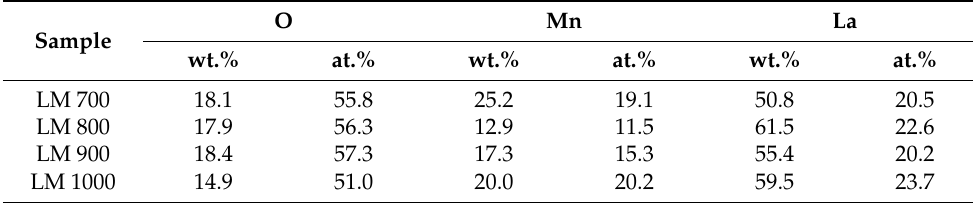
Table 4. Summary of the elemental compositions detected using EDX.